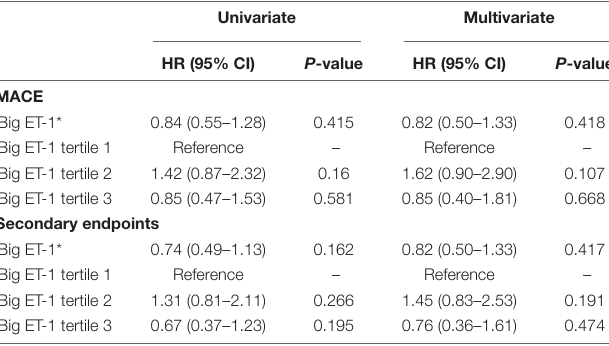
TABLE 5 | Cox proportional hazards models for prognosis in non-diabetic patients. Univariate